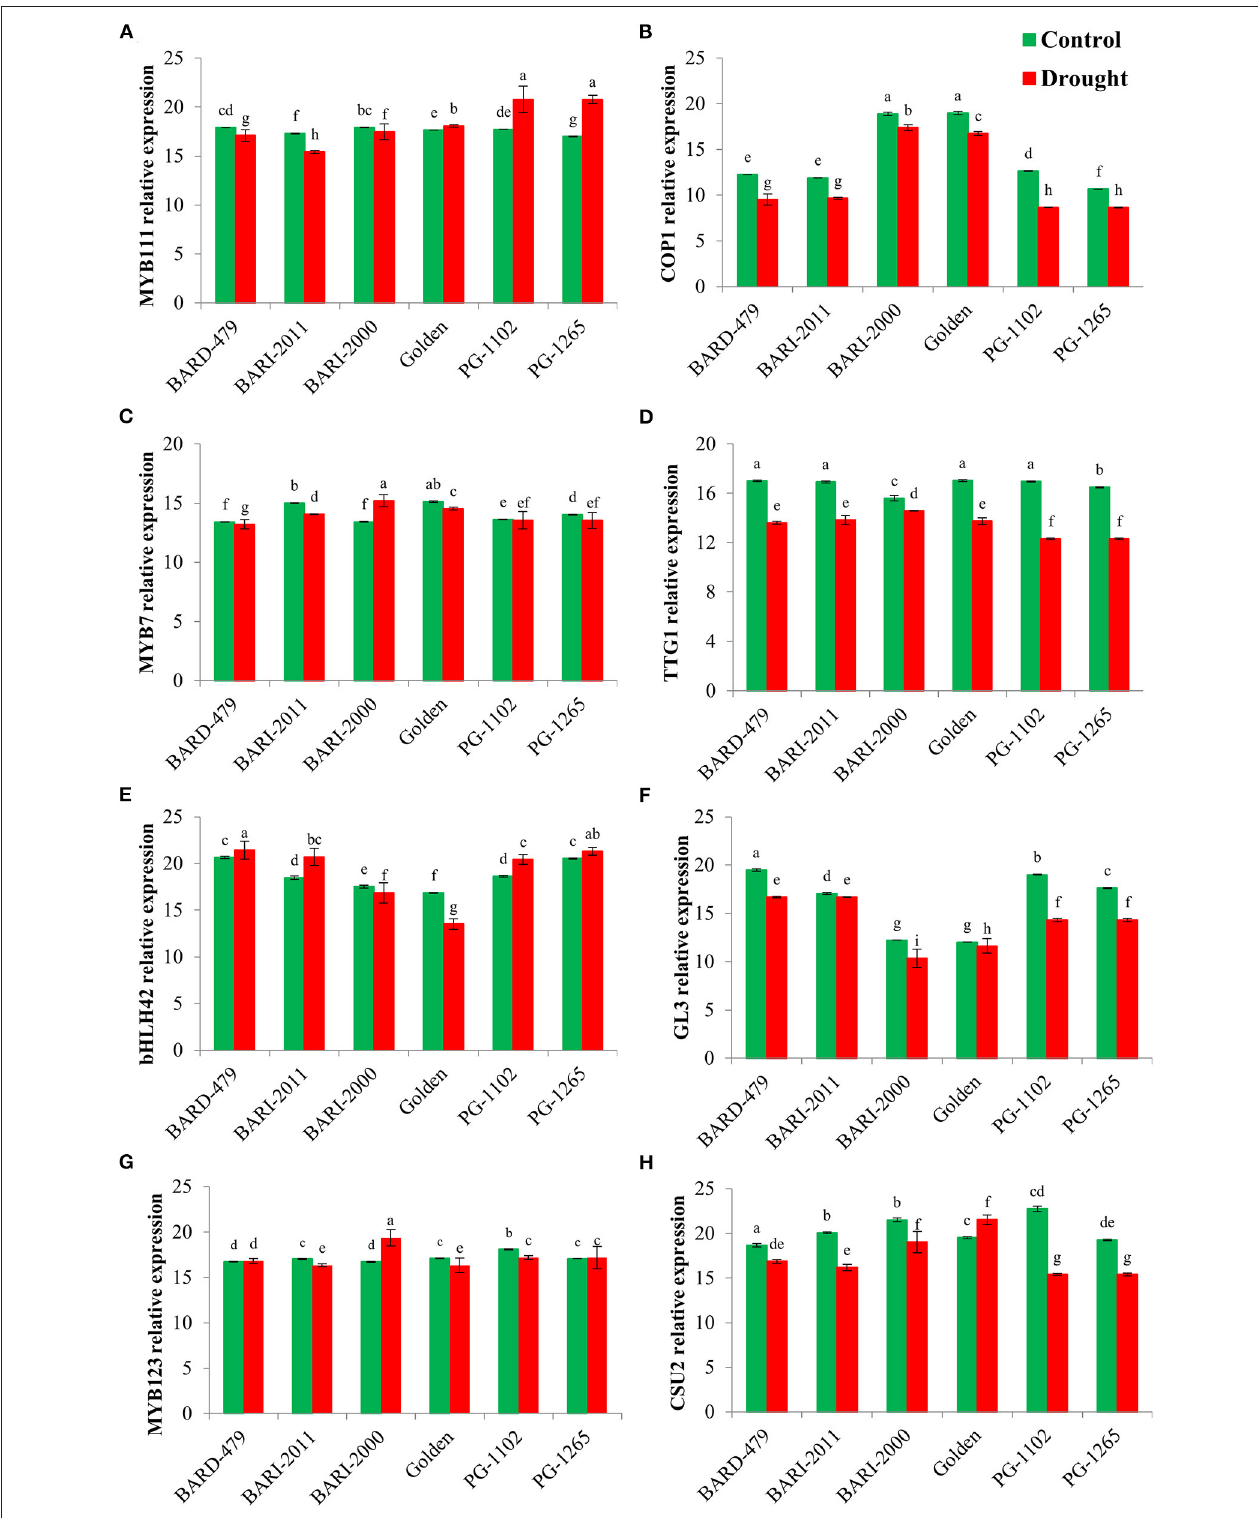
FIGURE 5 | Transcription factors (TFs) expression profile in leaves of genotypes of peanuts under drought stress. The panel shows the following: the MYB111 (A) , the COP1 (B) , the MYB7 (C) , the TTG1 (D) , the bHLH42 (E) , the GL3 (F) , the MYB123 (G) , and the CSU2 (H) . Data are shown as the interaction between the genotypes of peanut and the drought applied. Significance was inferred either with an ANOVA under the Tukey’s HSD post-hoc test for normally distributed data (Honest Significant Detection, p < 0.05). Non-parametric data were analyzed with a Kruskal–Wallis test under False Discovery Rate post-hoc correction (FDR, p < 0.05).